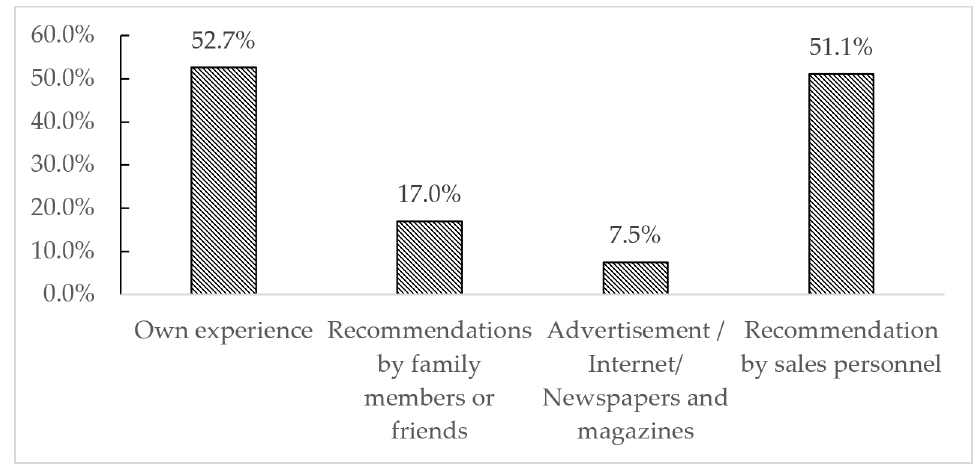
Figure 2. Ways of selecting drugs.